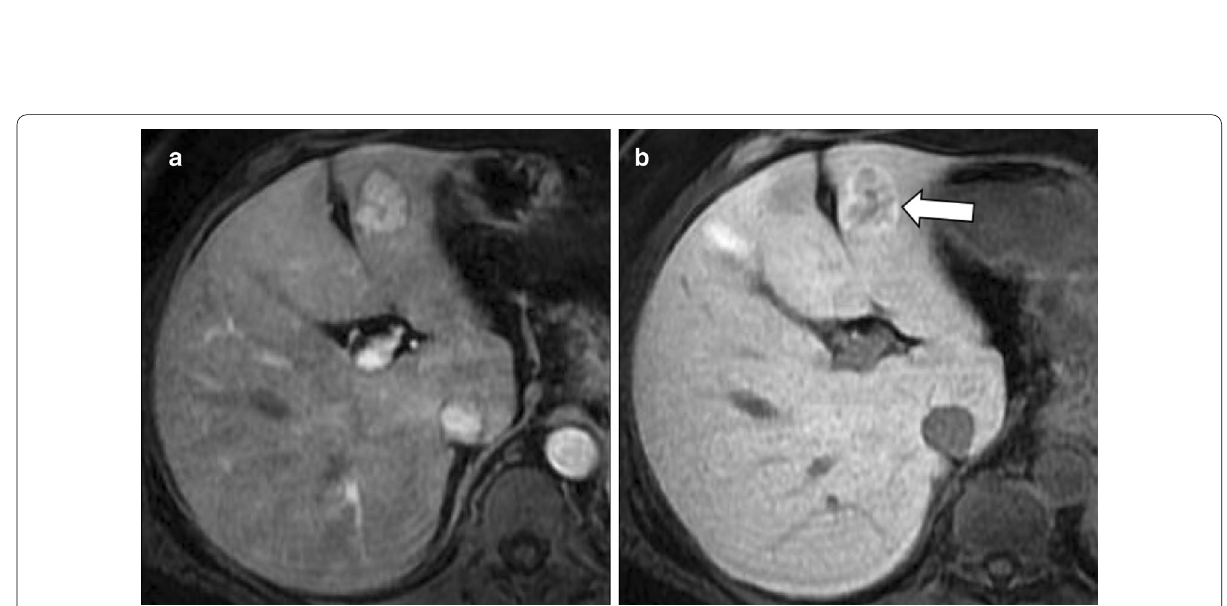
Fig. 3 A 44‑year‑old woman with focal nodular hyperplasia. Gadobenate dimeglumine‑enhanced MRI shows a focal nodular hyperplasia that is ( a ) hypervascular in the arterial phase and ( b ) demonstrates a hyperintense rim (arrow) in the hepatobiliary